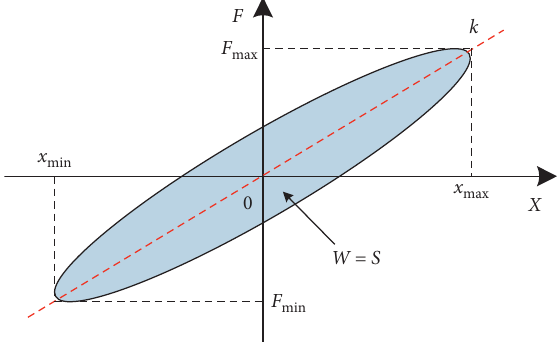
Figure 1: Force-displacement hysteresis curve of rubber